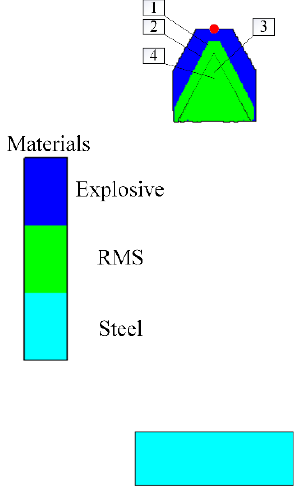
Figure 7. 3D simulation model. Table 1. The parameters of the Johnson–Cook constitutive model. Particle Size of Al ( µ m)